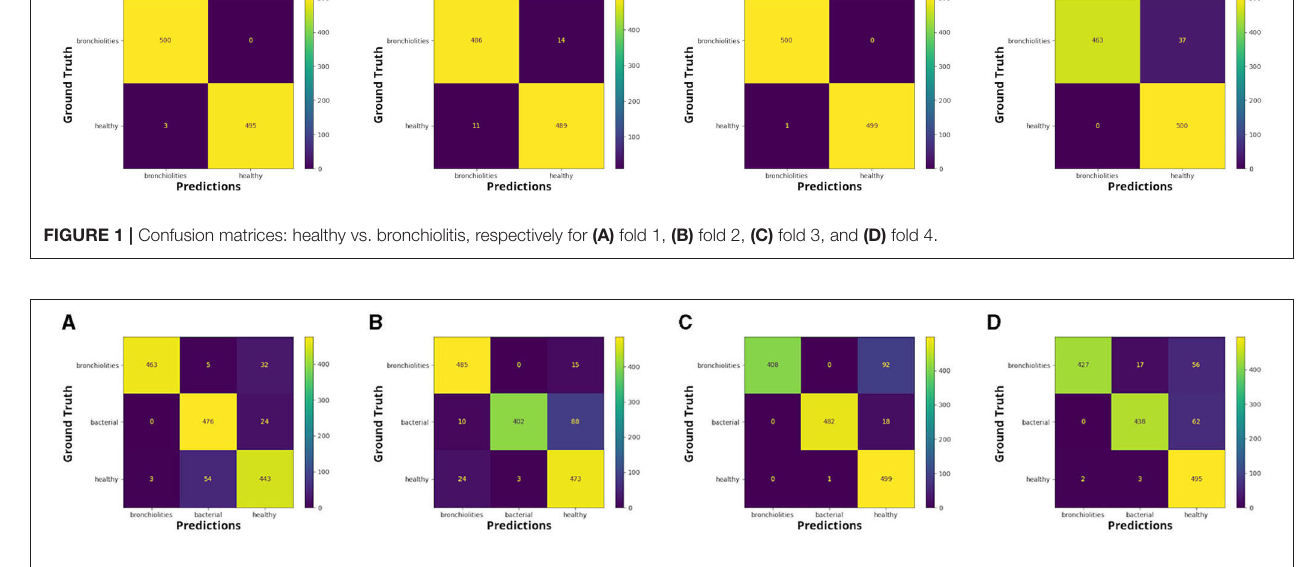
FIGURE 2 | Confusion matrices: healthy vs. bacterial pneumonia vs. bronchiolitis, respectively for (A) fold 1, (B) fold 2, (C) fold 3, and (D) fold